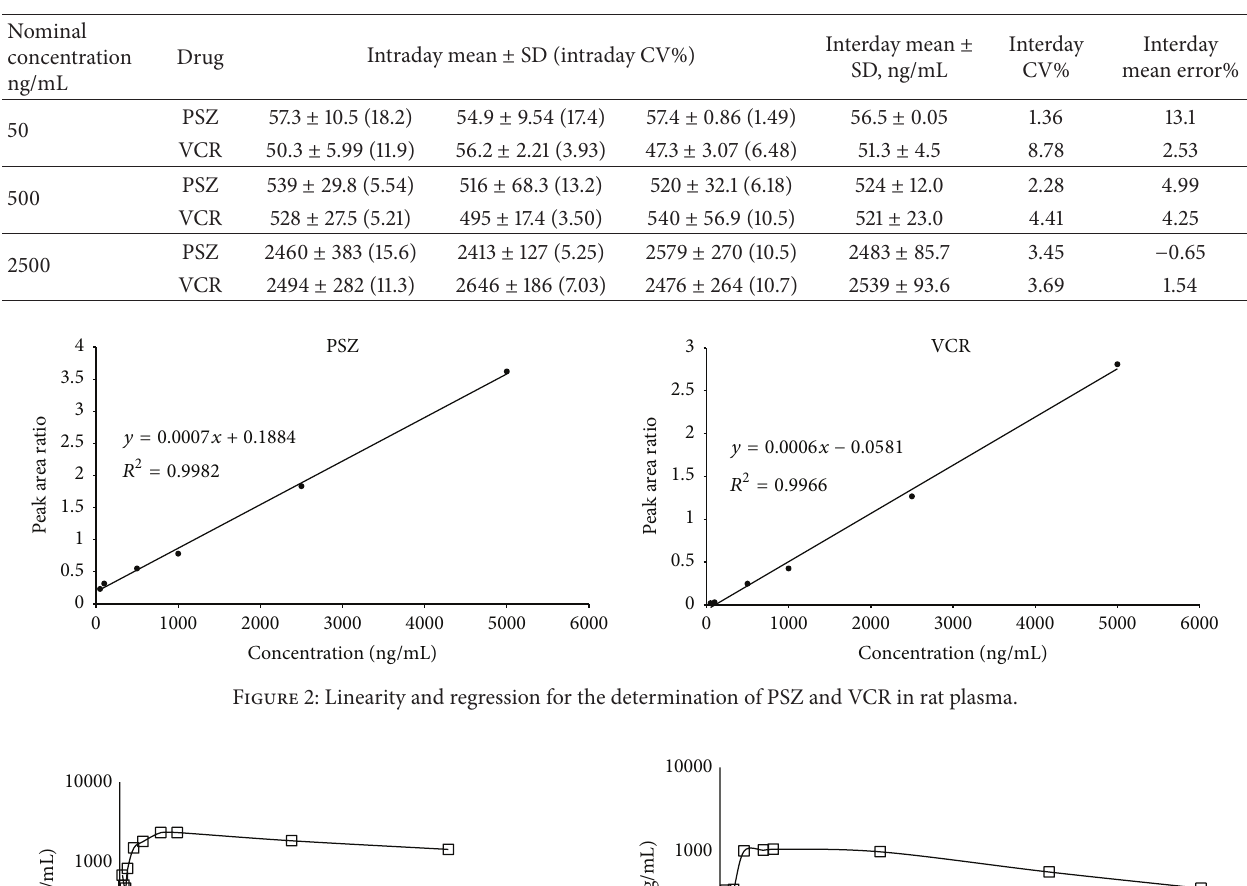
Table 1: Precision and accuracy for the determination of PSZ and VCR in rat plasma using the proposed HPLC-DAD method.